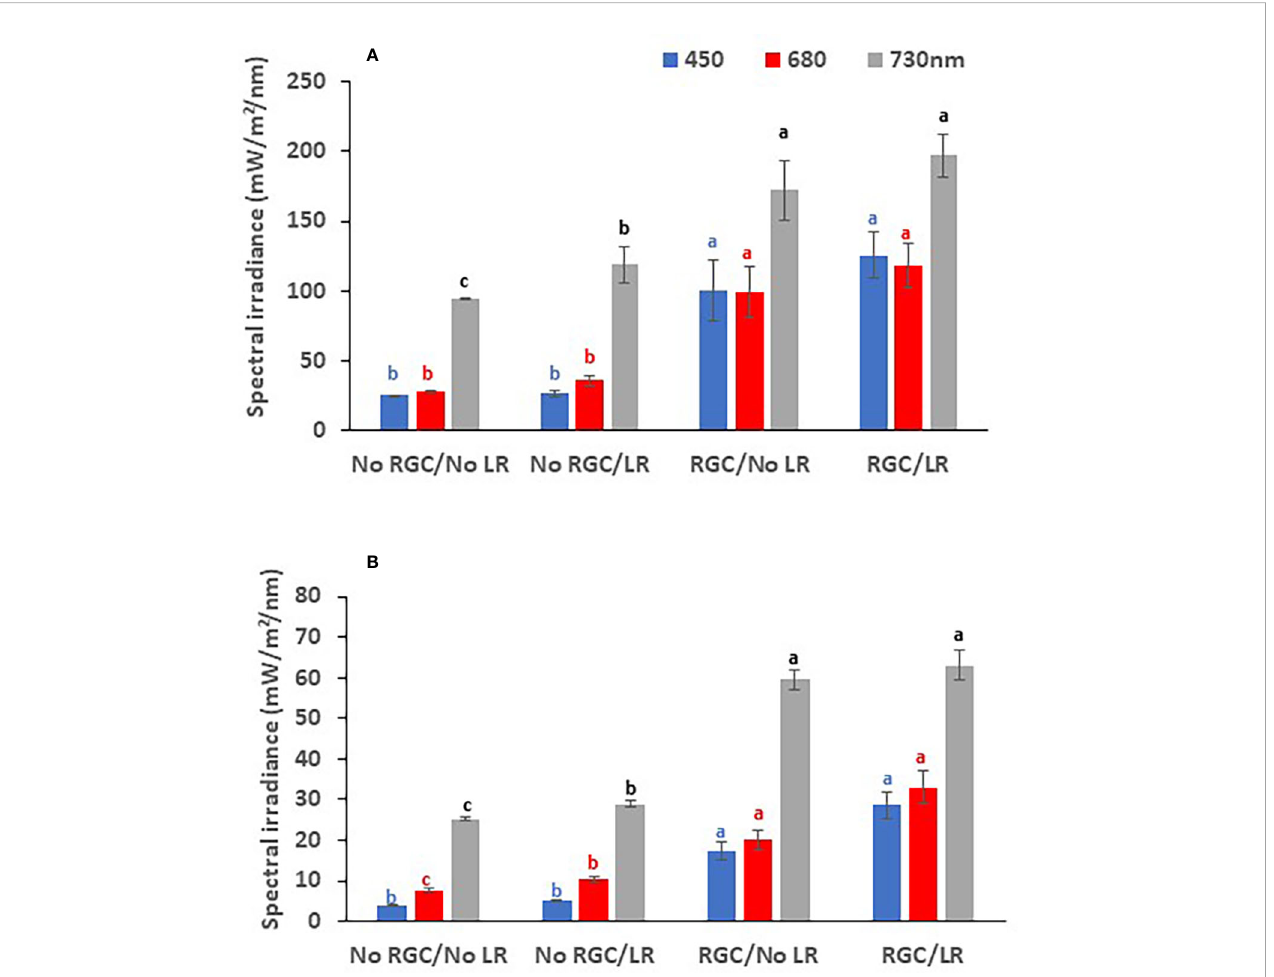
FIGURE 2 The quantity of re fl ected blue (at 450 nm), red (at 680 nm), and far-red (at 730 nm) lights measured at the cluster zone as affected by using light- re fl ective ground cover (RGC) and/or conducting the cluster-zone leaf removal (LR) in 2019 (A) and 2020 (B) . Values are the mean of four readings, and the error bars represent the standard deviation. Different colored letters on bars indicate signi fi cant differences in same light wavelength at p < 0.05 according to the Tukey HSD test within the same year. Data were recorded once at the mid-day of June 17 th , 2019, and June 19 th , 2020.